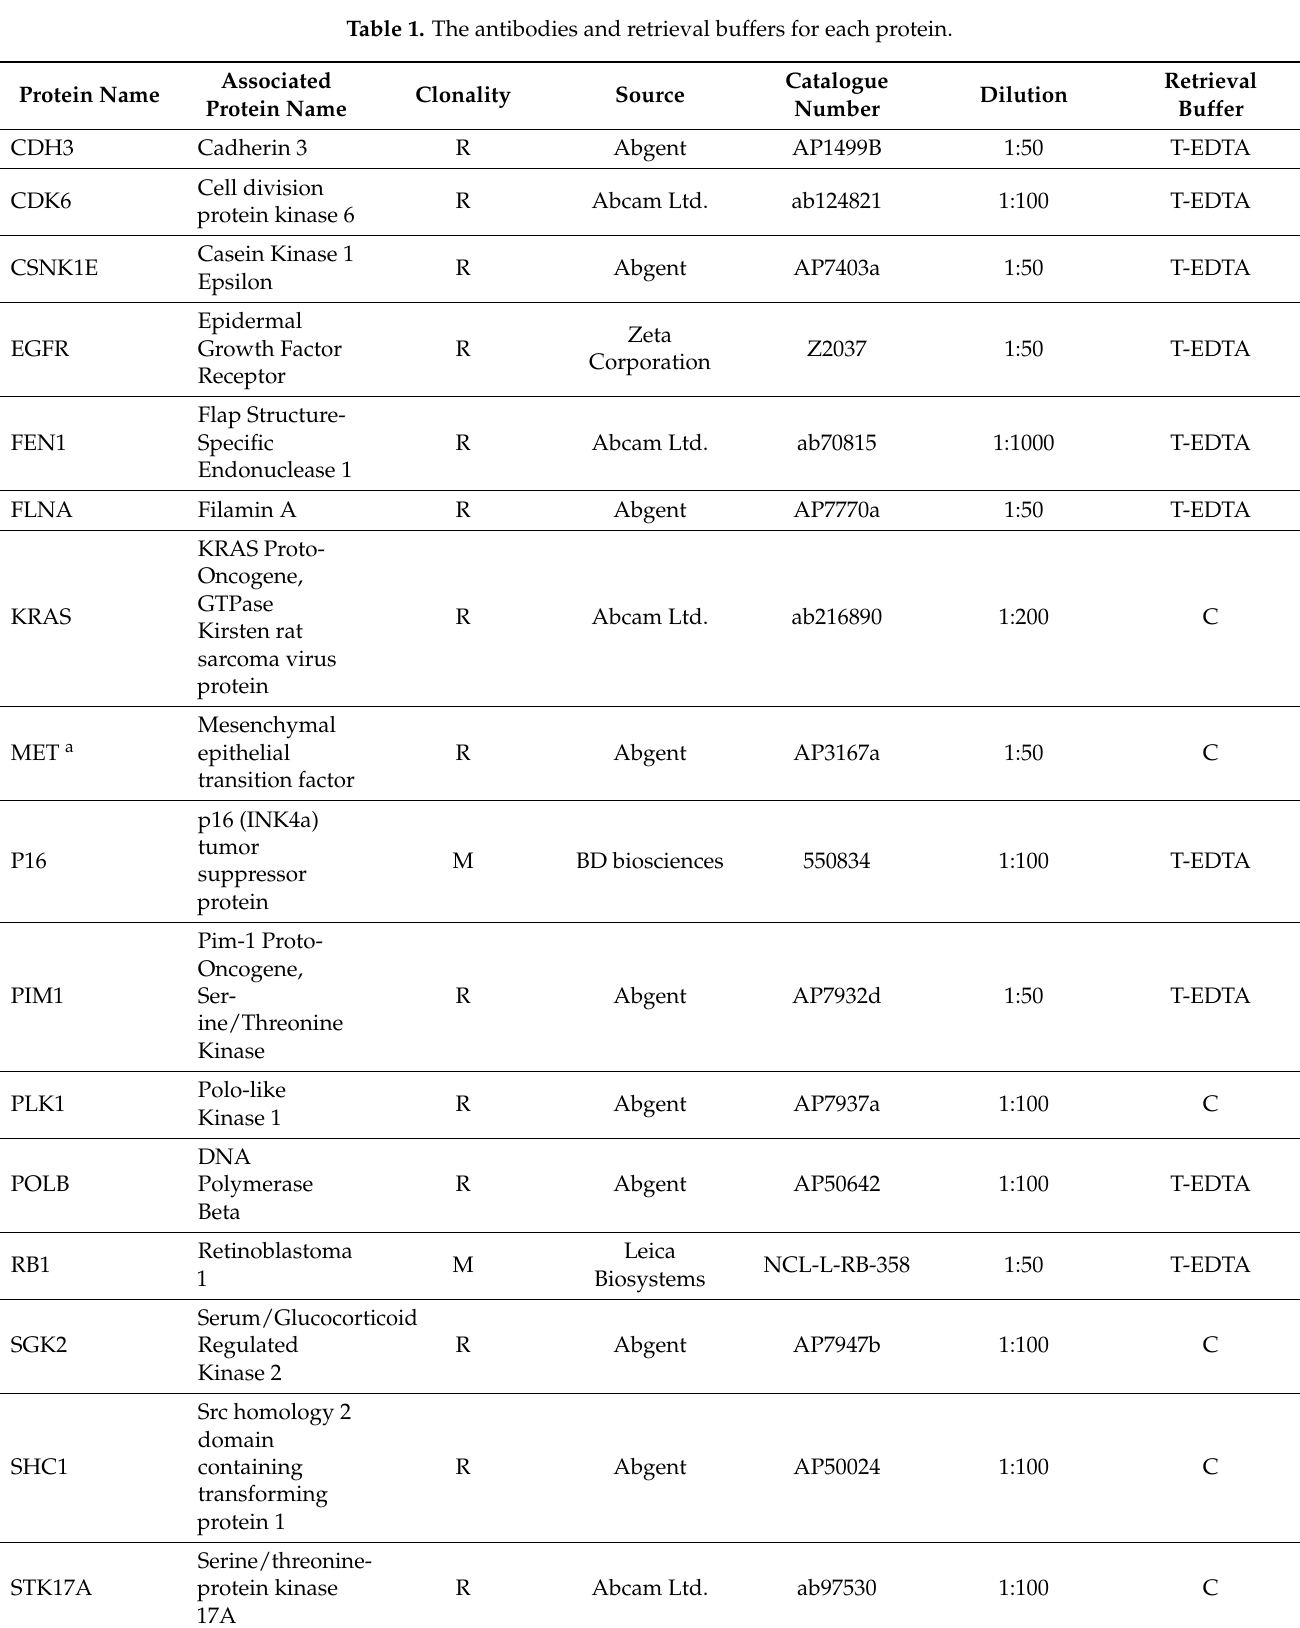
Table 1. The antibodies and retrieval buffers for each